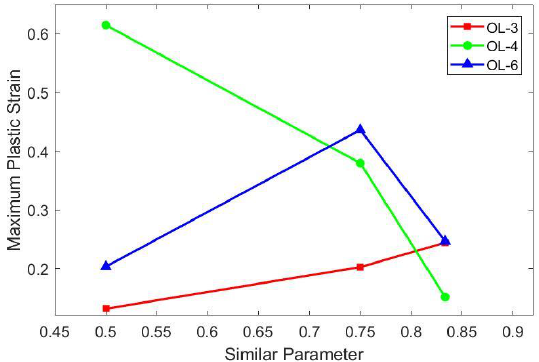
Figure 19. The FEM results of the maximum plastic strain of the panels.